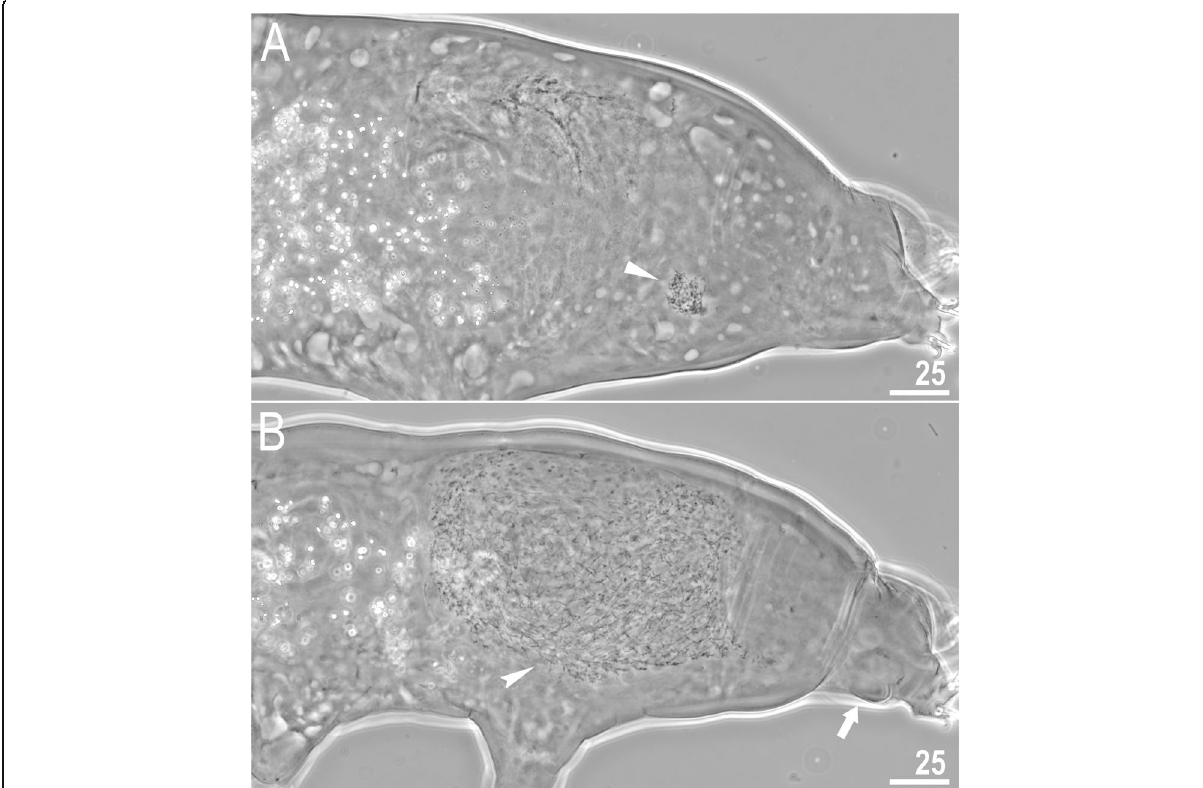
Fig. 20 Macrobiotus pseudopallarii sp. nov. from Montenegro (ME.007) – reproduction (LCM): a – spermatheca (seminal vesicle) filled with spermatozoa and visible in females freshly mounted in Hoyer ’ s medium; b – testis filled with sperm visible in a male freshly mounted in Hoyer ’ s medium. The flat arrowhead indicates the female spermathecae, the indented arrowhead indicates the testis, and the arrow indicates the gibbosity on the IV leg. Scale bars in μ